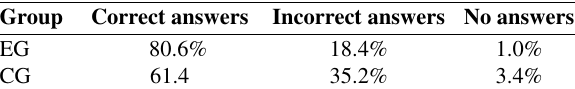
Table 1. Formation 1-chlorobutane, percentages of correct and in- correct answers. Group